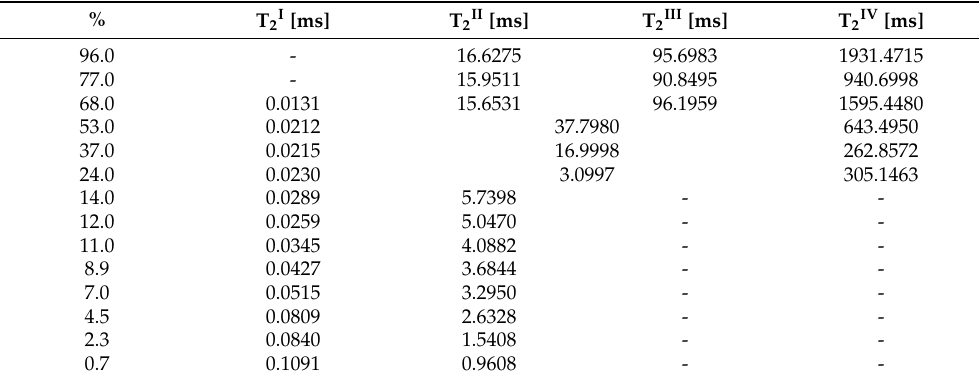
Table A1. Line position for MCM-41 in series of water saturations. I—OH groups, II—intra pore water, III—inter pore water, IV—free water.